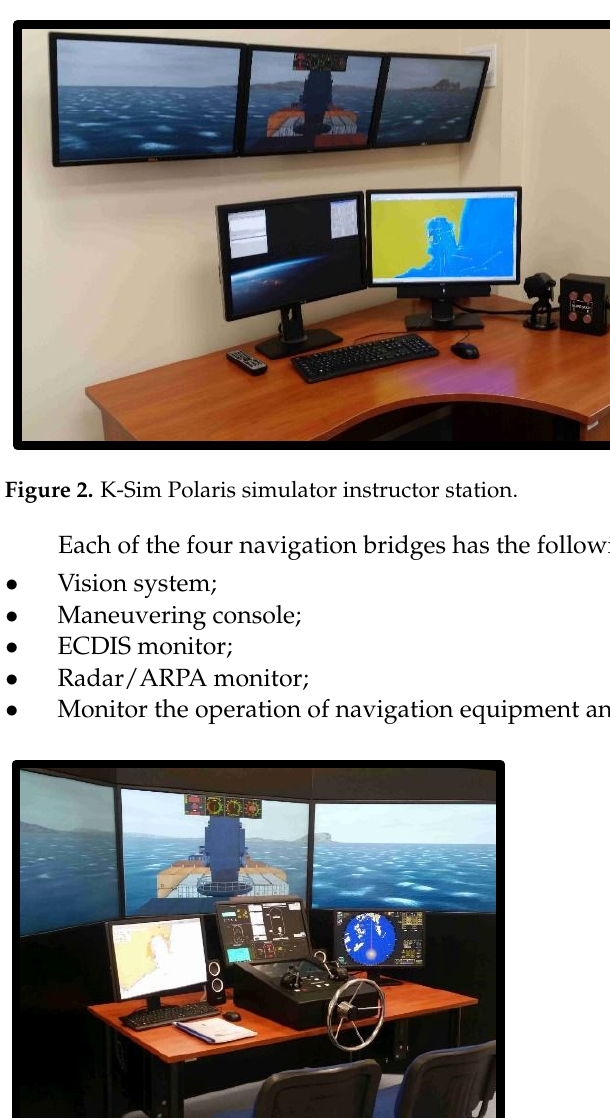
Figure 2. K-Sim Polaris simulator instructor station. Figure 3. View of simulator navigation bridge. Figure 3. View of simulator navigation